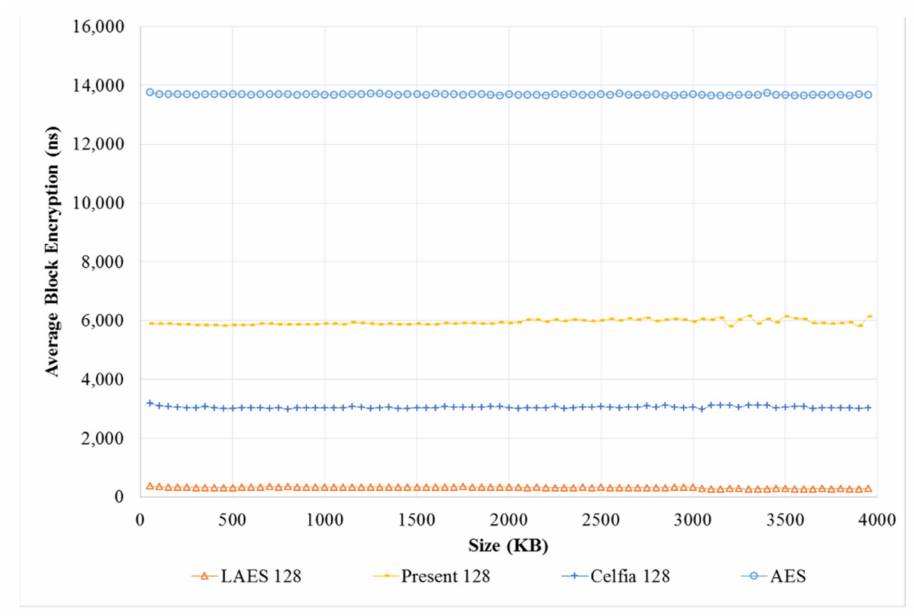
Figure 8. Average encryption time for a single block.